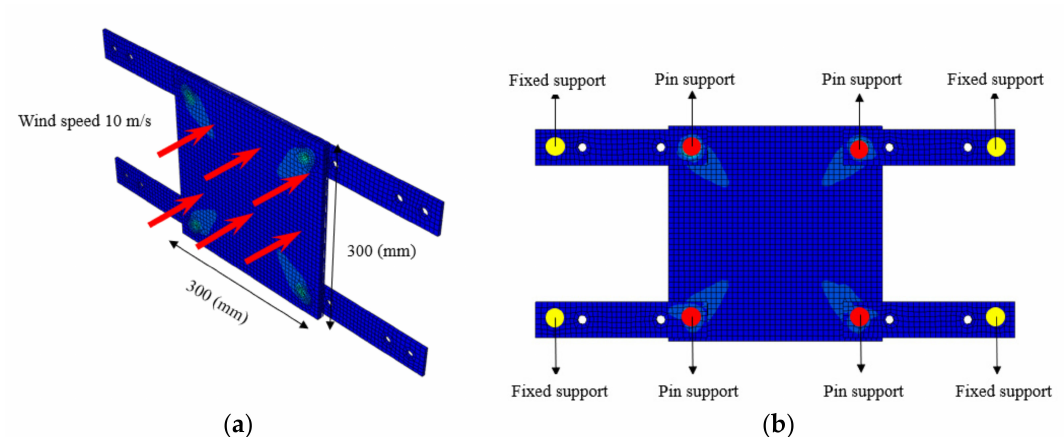
Figure 15. Finite element modeling: ( a ) front view; ( b ) rear view.